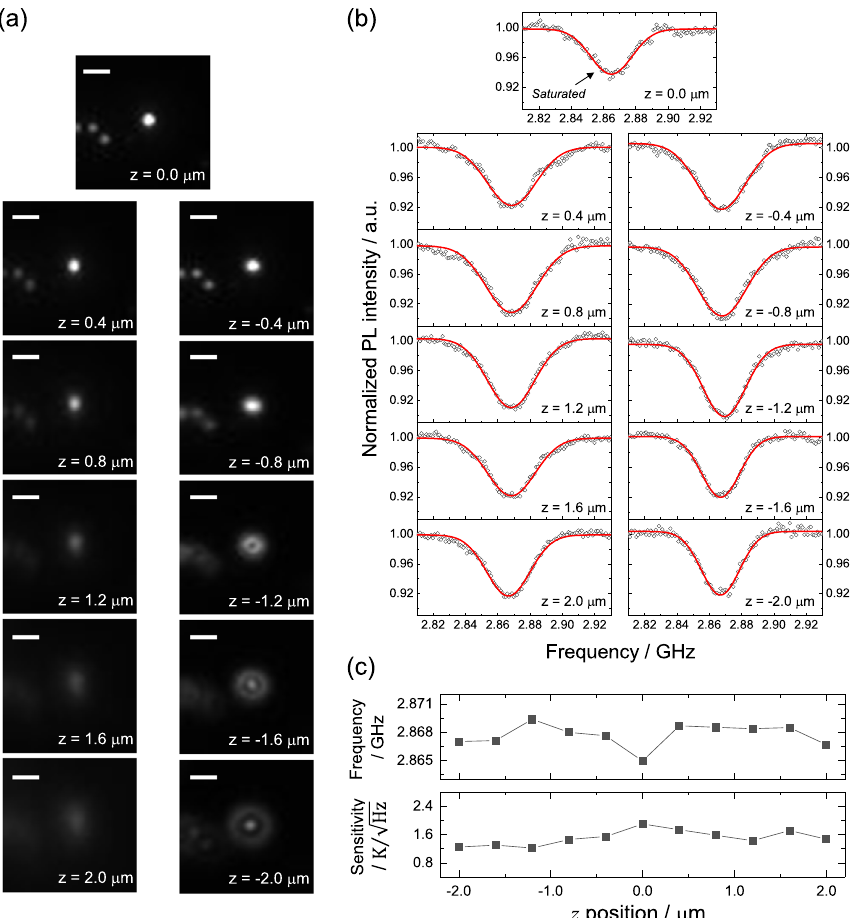
Figure 4. ( a ) Fluorescence images of a single ND with z -positional shift of ± 2 µ m with respect to the exact focus ( z = 0 µ m ) and ( b ) the corresponding ODMR spectra. Scale bar: 2 µ m . ( c ) Variation of the central frequency of the ODMR spectra (top) and the estimated temperature sensitivity. n acc = 50 and (cid:31) t exp = 10 ms were used for all the measurements. Note that the fluorescence spot was saturated at z = 0 to obtain a sufficient SNR at the most defocused place of z = ± 2 µ m .